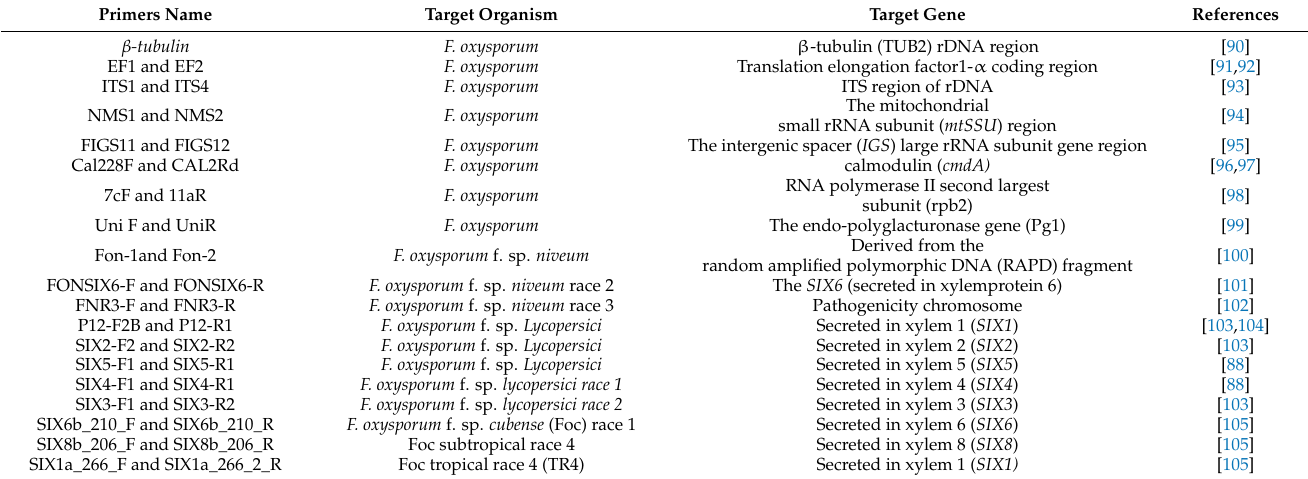
Table 3. PCR primers used to detect F. oxysporum , F. oxysporum formae speciales, and their